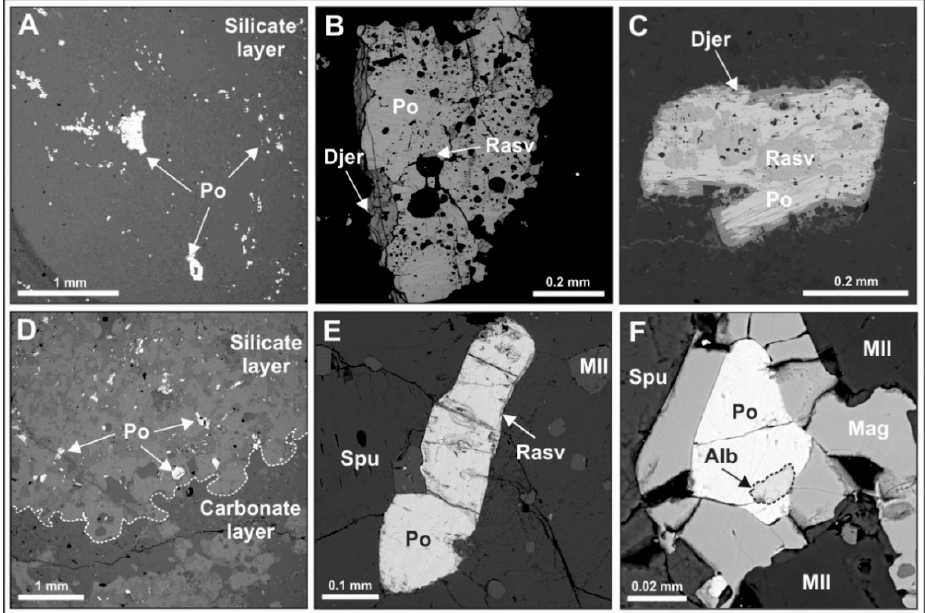
Figure 10. Backscattered electron (BSE) image showing the distribution and typical appearance of pyrrho-tite grains in recrystallized marly limestones ( A – C ) and marbles ( D – F ) from the Kochumdek contact aureole. Recrystallized marly limestones: ( A ) Distribution and relationship of matrix sulfides (mainly pyrrhotite) hosted by silicate layer. ( B , C ) Typical anhedral grains of pyrrhotite with a particular spongy structure, partly replaced by later K-Fe sulfides (rasvumite and djerfisherite). Pyrrhotite grains are located in fine-grained silicate layers (calcite + plagioclase + clinopyroxene + K-feldspar). Marbles: ( D ) Distribution and relationship of sulfide grains (mainly pyrrhotite) in the matrix, located at sili-cate layers and on boundary with carbonate layers. ( E ) Typical euhedral pyrrhotite grain with thin rasvumite rim. ( F ) Pyrrhotite grain is overgrown by magnetite. The boundaries of magnetite rim are roughly parallel and generally mimic the contours of primary pyrrhotite grain with small alabandite inclusion. Samples: A – C = PK-16-1, D – F = PT-104. Alb = alabandite, Djer = djerfisherite, Mag = magnetite, Mll = meli-lite, Po = pyrrhotite, Rasv = rasvumite, Spu =